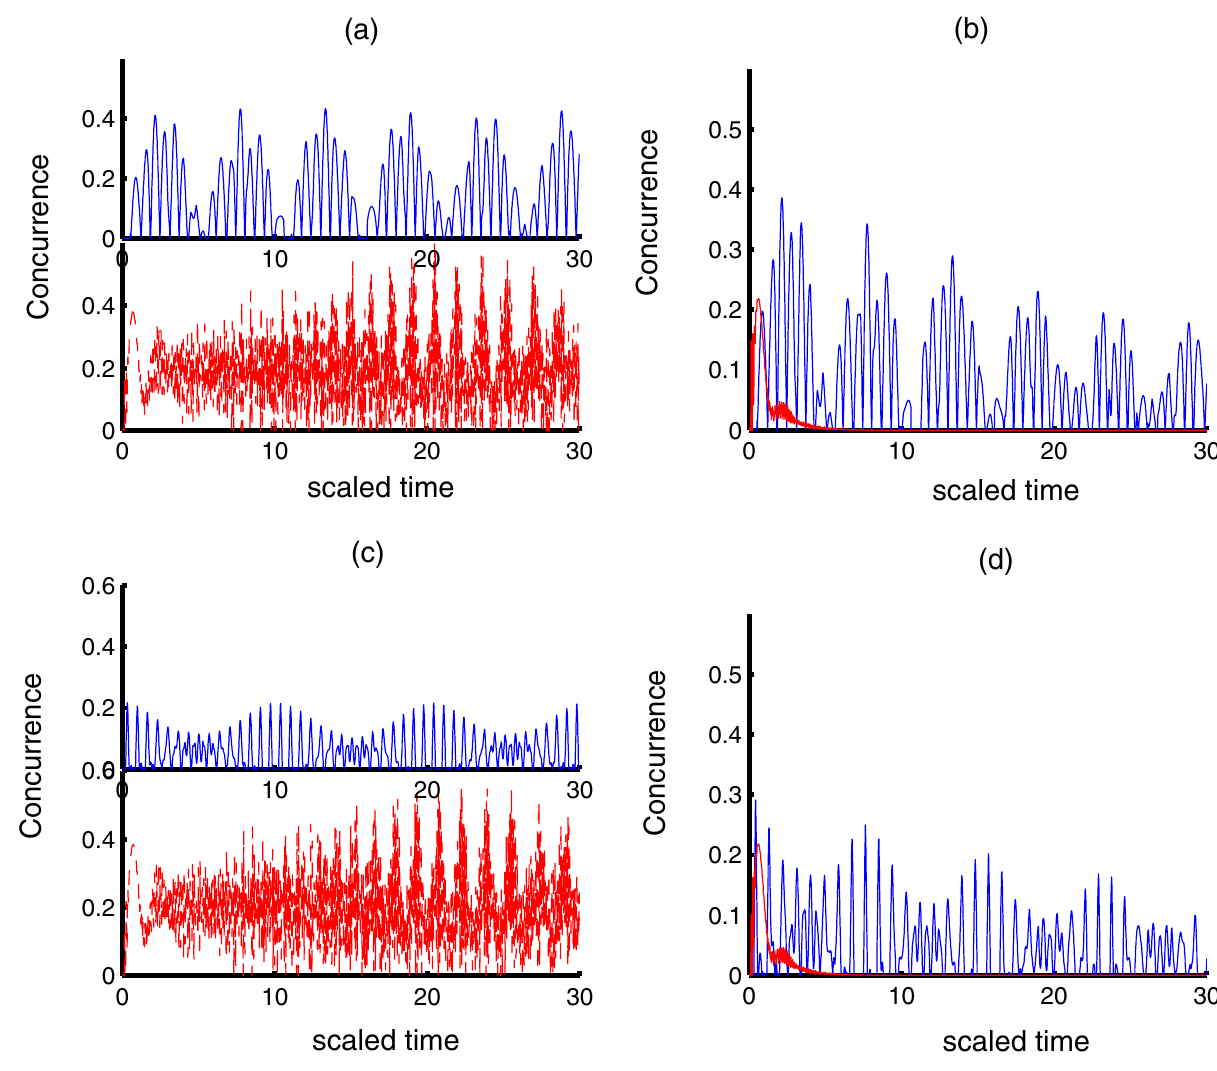
Figure 3. Time evolution of the Concurrence for the same conditions and parameters of Fig.